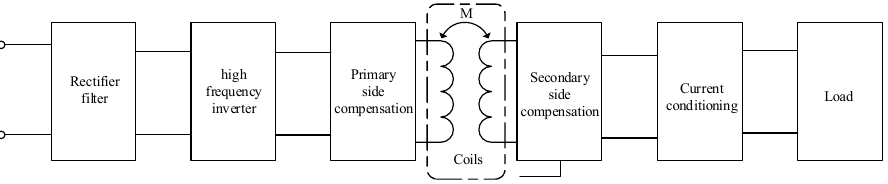
Figure 1. Basic structure of MCR-WPT system.